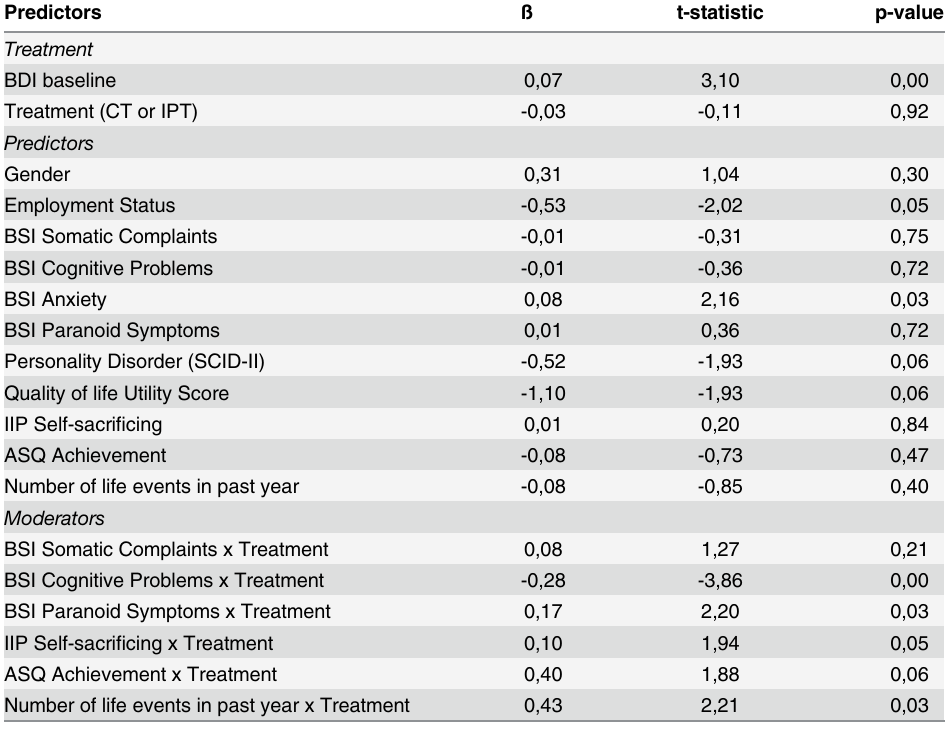
Table 2. Final Prediction